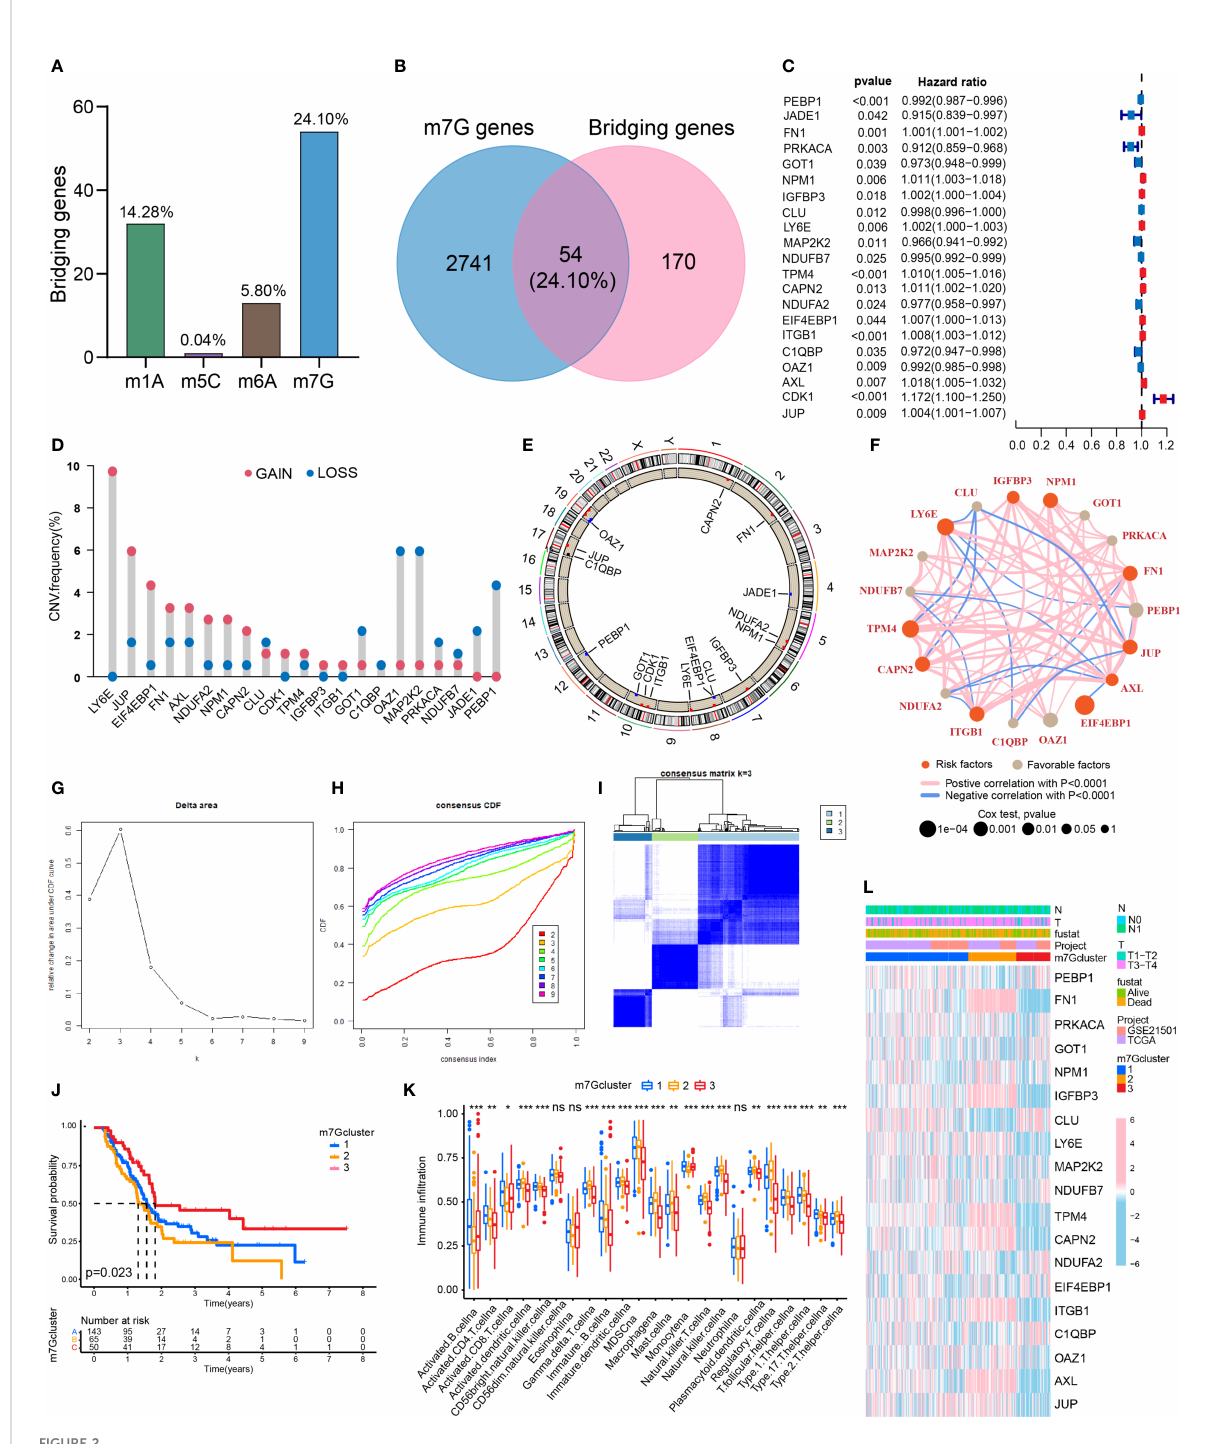
FIGURE 2 Classi fi cation of PDAC based on m7G methylation related bridging genes. (A) The proportion of four common methylation type genes in bridging genes. m7G methylation genes have the highest proportion. (B) Intersection of the bridging genes and the m7G methylation genes. (C) Univariate Cox analysis of the m7G methylation genes. (D) Diagram of the frequency of copy number variations in the m7G methylation genes. (E) Copy number circle diagram for the m7G methylation genes. (F) Prognostic network of the m7G methylation genes. (G – I) Classi fi cation of pancreatic cancers based on m7G methylation related bridging genes. Changes in the length and inclination of the CDF curve for k=2 – 9. Area under the cumulative distribution function curve for k=2 – 9. Division of the pancreatic cancer samples into three clusters. (J) Kaplan – Meier survival curves of the three clusters. (K) Immune cell in fi ltration of the three clusters. *p<0.05; **p<0.01; ***p<0.001; ns, no signi fi cance. (L) Heat map of pancreatic cancer classi fi cation, m7G methylation genes, and clinicopathological